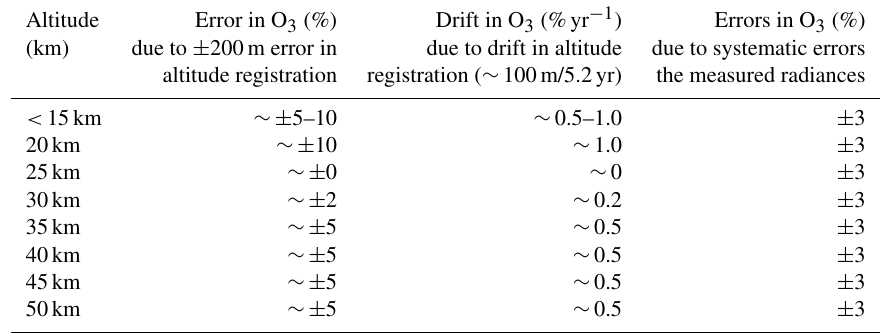
Table 2. Known systematic errors in OMPS LP ozone retrievals.